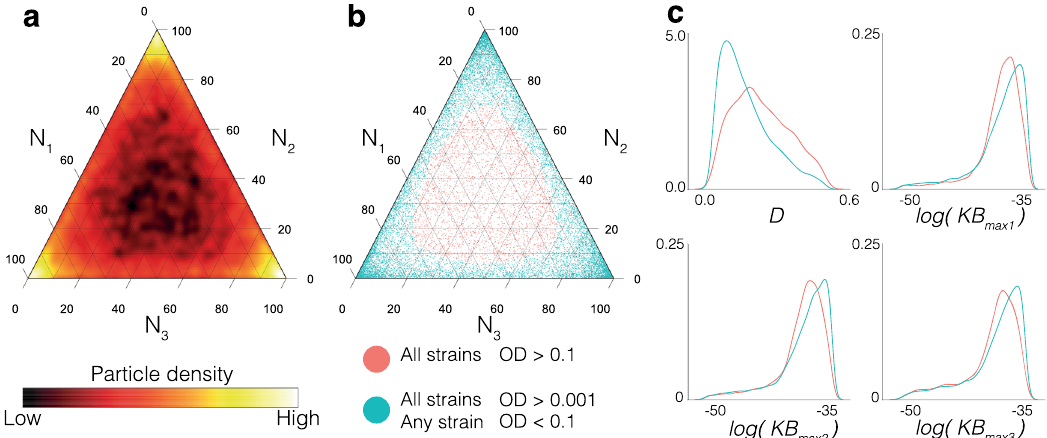
Fig. 6 Distribution of population densities in model 4119. Axes of ternary diagrams ( a and b ) show percentage composition of the community. a Heat map showing the community composition at stable steady state in model 4119. Axes refer to percentage representation for each strain in the community. b Scatter plot of the stable steady state systems, highlighting the secondary threshold where all strains have OD > 0.1 (red), and the primary objective only where any strain has 0.001 < OD < 0.1. c Density plots comparing the parameter distributions of four parameters that show the greatest divergence to produce the secondary threshold: Dilution rate ( D ) and maximal bacteriocin expression rates ( KB max1 , KB max2 , KB max3 ). The Kolmogorov – Smirnov values for the two objectives are 0.25, 0.12, 0.13 and 0.12,